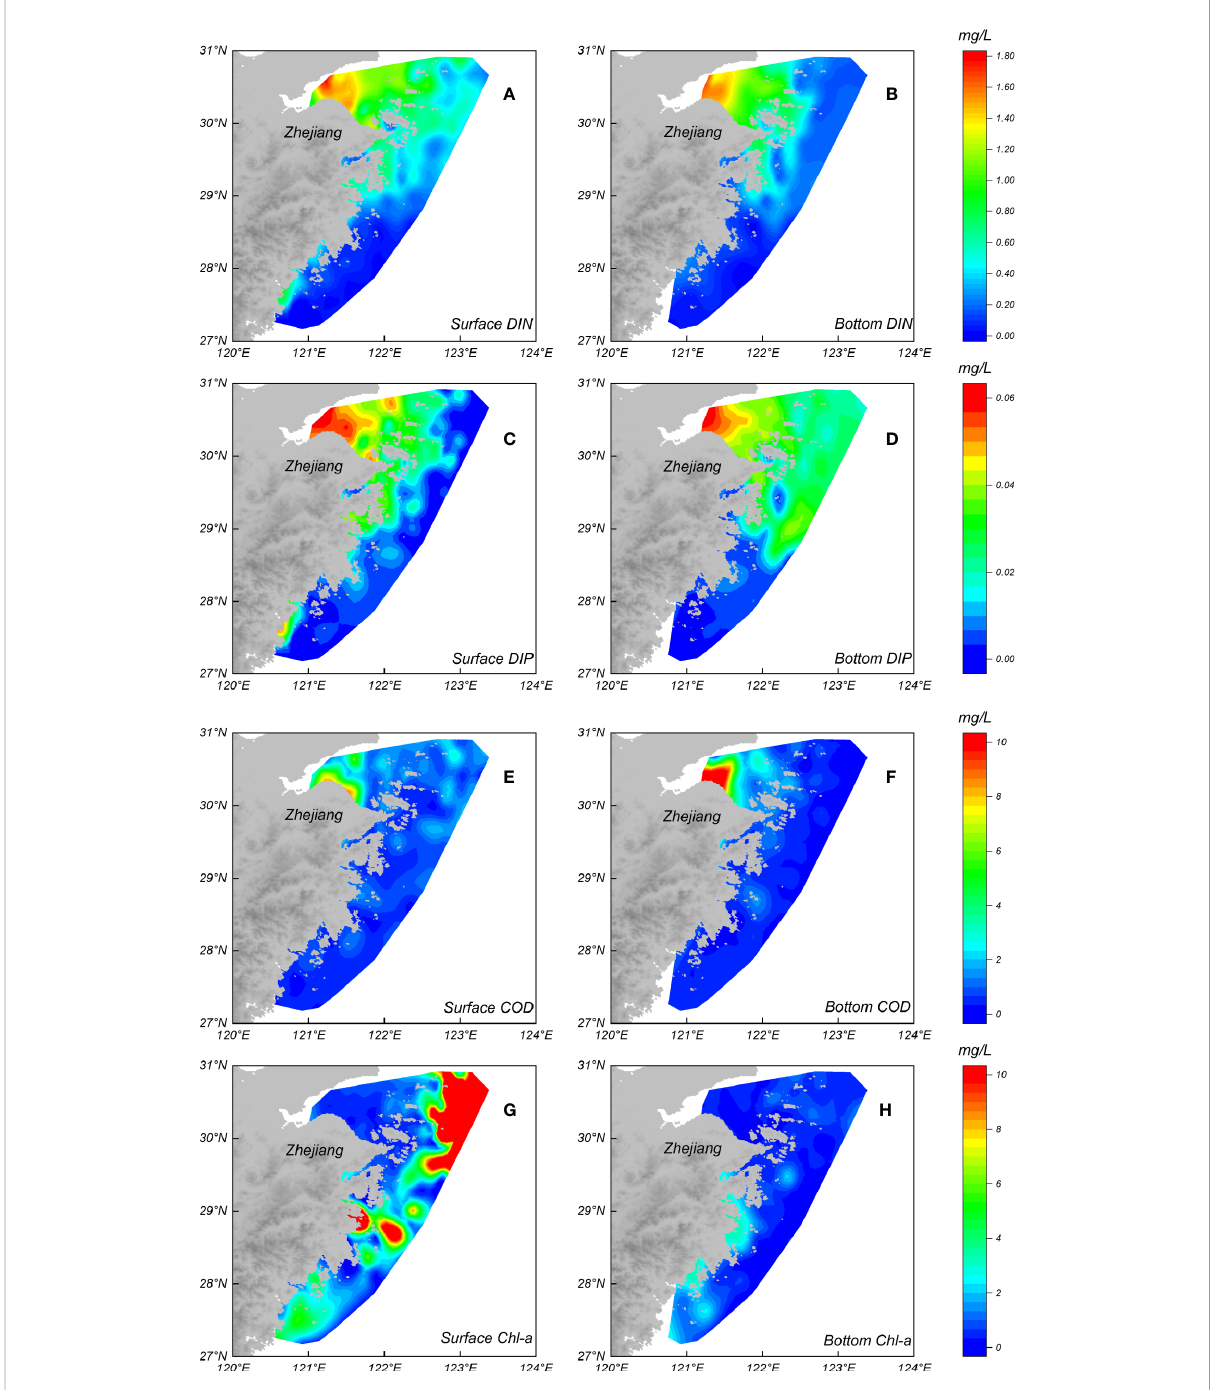
FIGURE 4 The horizontal distribution of (A) surface DIN, (B) bottom DIN, (C) surface DIP, (D) bottom DIP, (E) surface COD, (F) bottom COD, (G) surface Chl- a and (H) bottom Chl- a in the Zhejiang Coastal